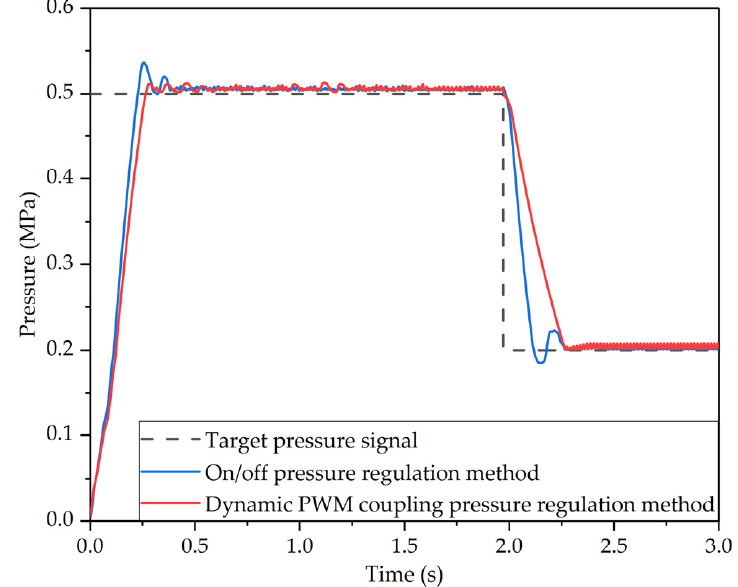
Figure 9. The outlet pressure response characteristic curve of the LF-APRV with different pressure regulation modes.